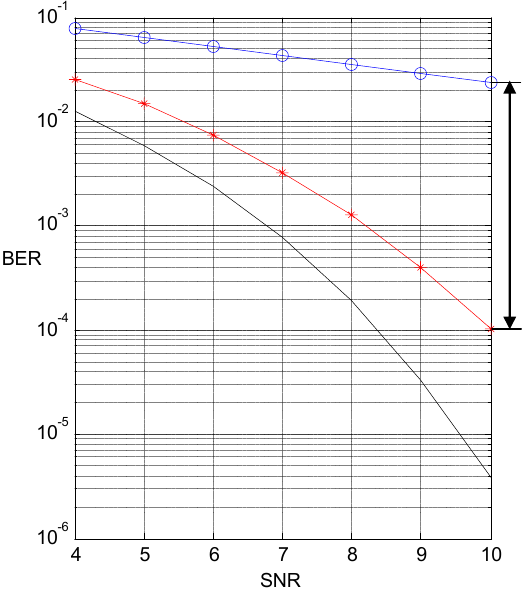
Figure 4. BER curves for a single correlator receiver with interleavers in presence of AWGN and fading: theoretical (blue) for fading, simulated (red) for fading with interleavers and theoretical for noise only